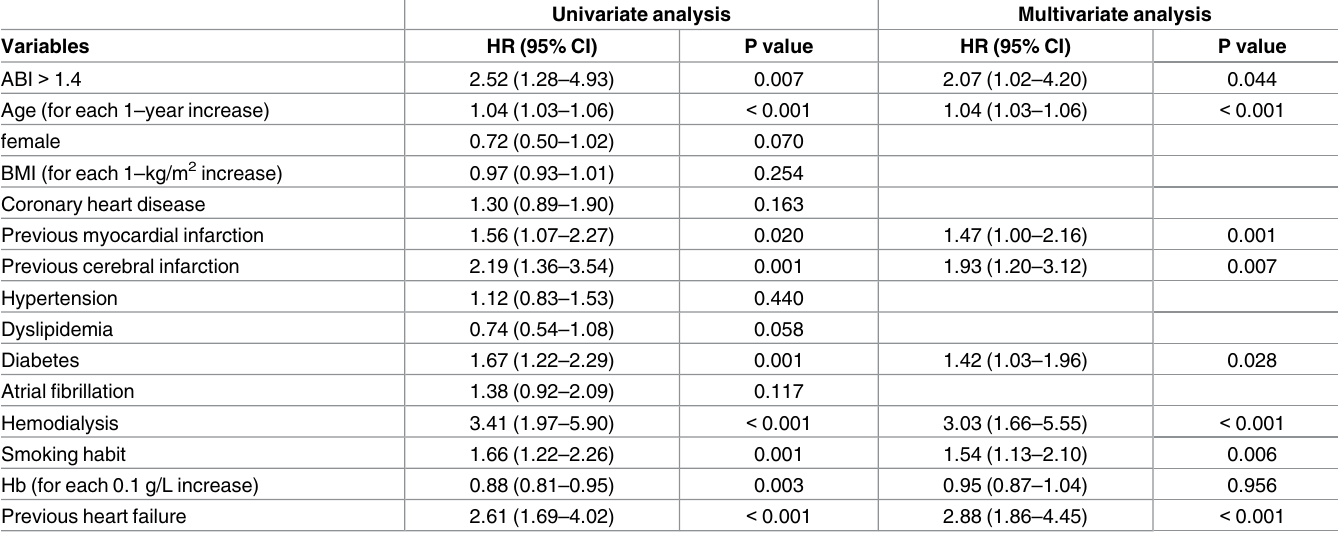
Table 3. Univariate and multivariate Cox proportional hazard analysesfor MACE. Univariate analysis Multivariate analysis